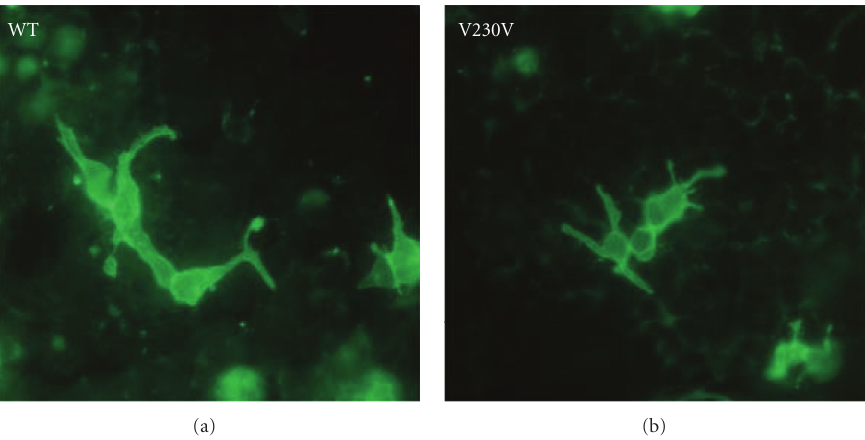
Figure 8: Allelic variant human opsin construct. The hhRz cleavage site at V230 (GUC ↓ ) was mutated by site-specific mutagenesis to the degenerate human valine codon GUG. The V230V human opsin cDNA in a CMV expression vector (pCDNA3) was expressed in HEK293S cells along with control human WT opsin CMV expression vector. Immunocytochemistry with 1D4 opsin monoclonal and an FITC-labeled secondary antibody was conducted. Abundant human WT opsin expression and cell surface tra ffi cking was noted in cells expressing WT (a) or V230V a WT proteins (b).